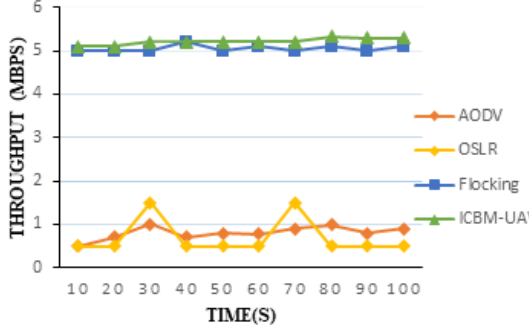
Figure 11. Throughput over time with obstacles.